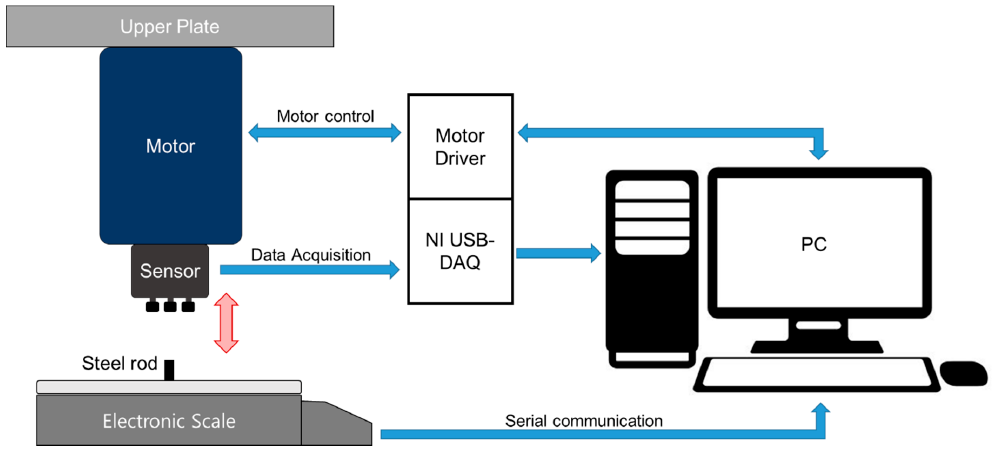
Figure 5. Schematic diagram of the sensor assessment system.